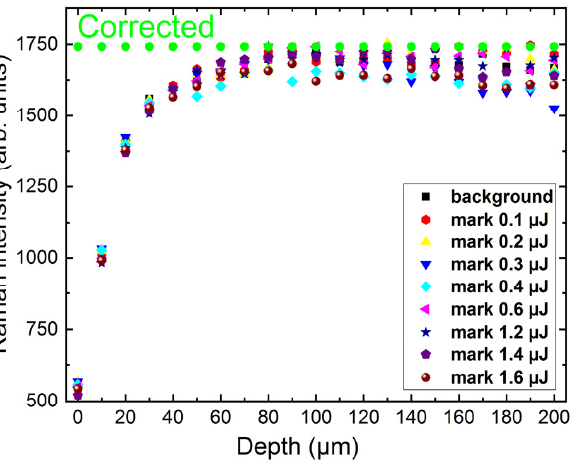
Figure 5. Dependence on depth z (µm) for different incident pulse energies at Raman ~ 428 nm. Unlike the previous case, blue excitation of PL indicates dramatic spatial and spectral variation of the PL yield of unmodified diamond (Figure 6a), which is caused by the spatial variation in the optical-center distribution inside the diamond